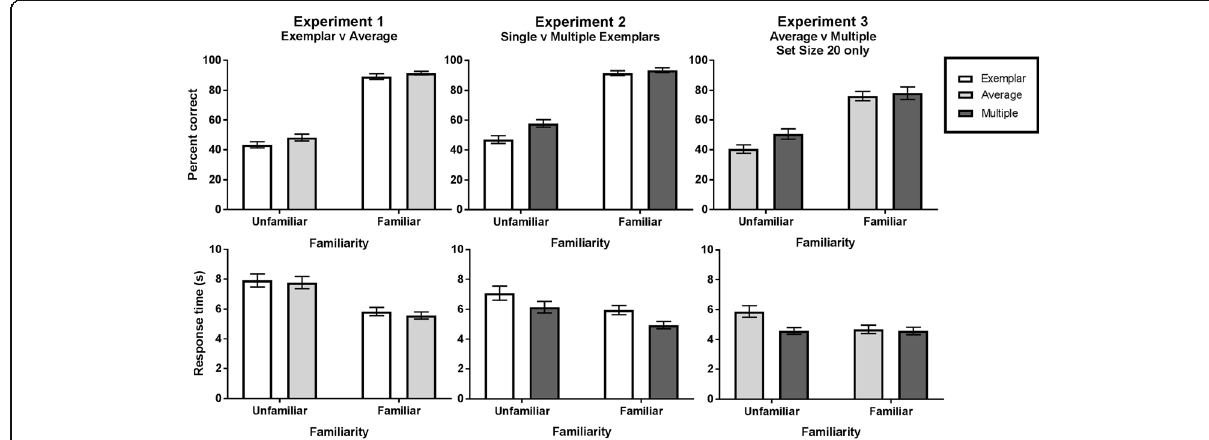
Fig. 2 Mean accuracy and response time for each experiment. To add comparison between experiments, the results for Experiment 3 only include the Set Size 20 condition. Error bars denote ±1 standard